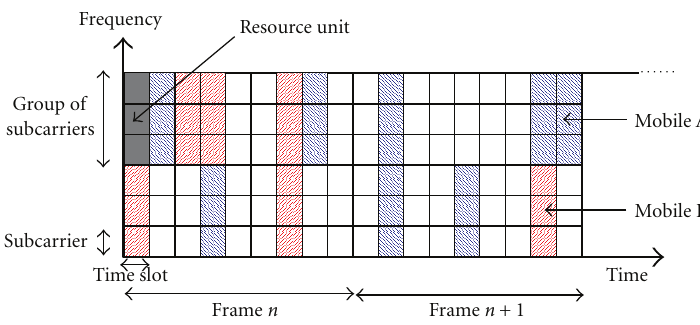
Figure 1: Frame structure in TDD mode ( n sub = 6 and n g = 2).